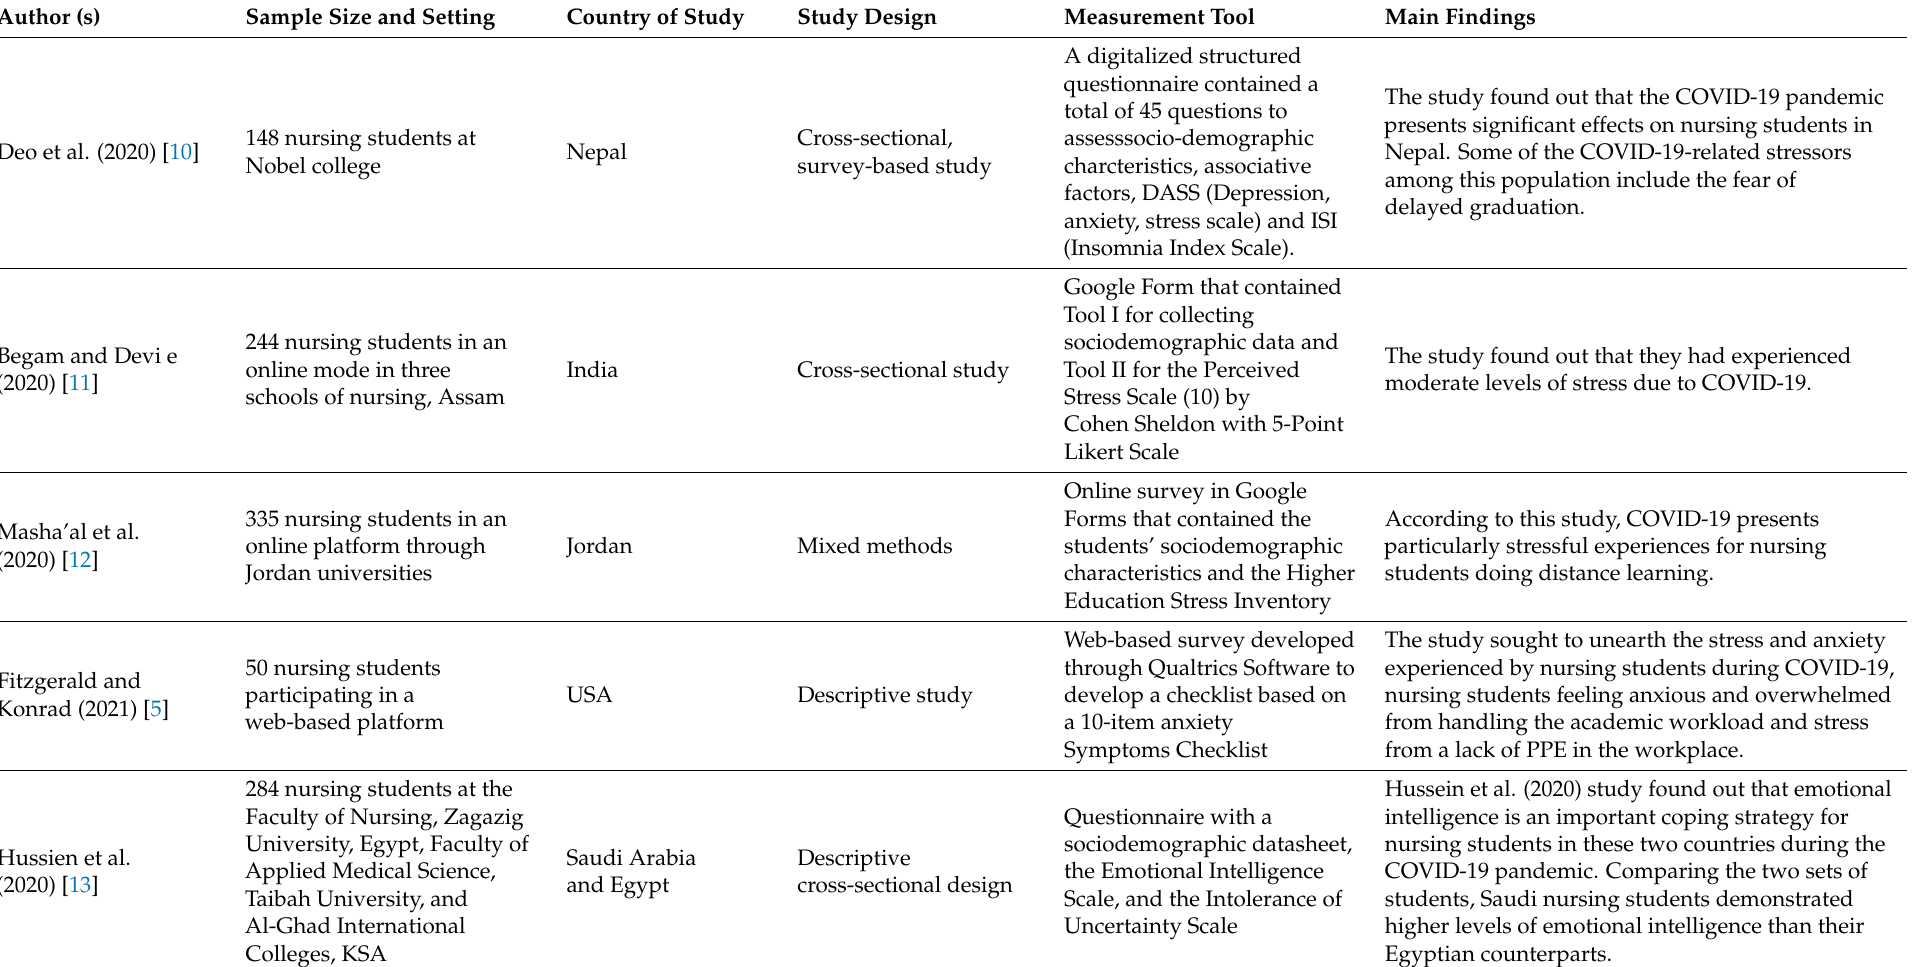
Table 3. Characteristics of the reviewed